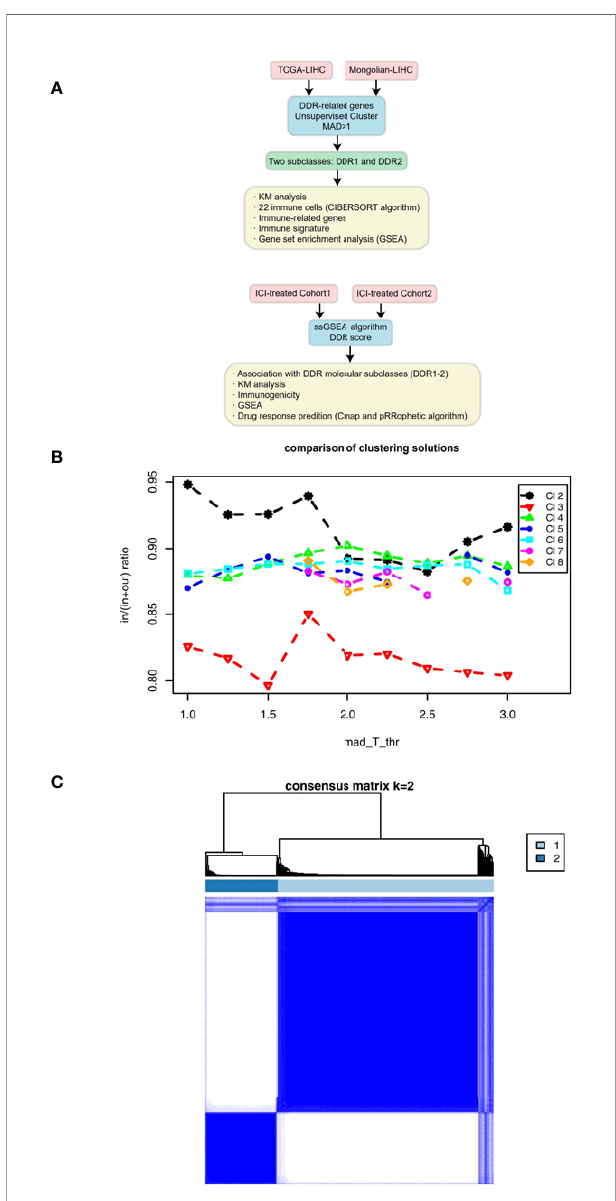
FIGURE 1 | (A) Overview of the data processing in this study. (B) Mean coclustering ratio vs MAD threshold (in = mean pairwise coclustering within a cluster, out = mean pairwise coclustering across clusters), which was used as the objective function to fi nd the optimal solution. (C) Coclustering matrix for a solution with 2 clusters and MAD threshold =